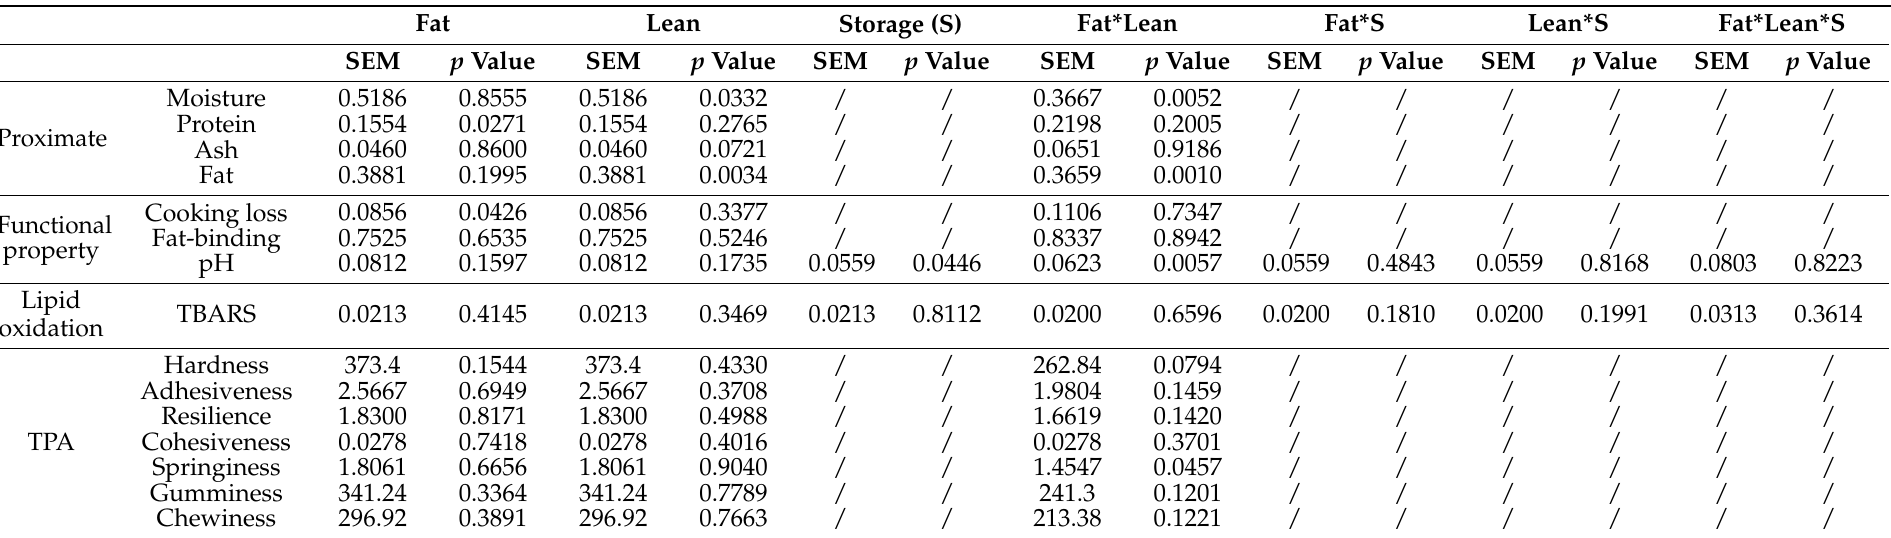
Table 2. Main and interactive effects of fat source, lean source, and storage period on quality attributes of emulsion